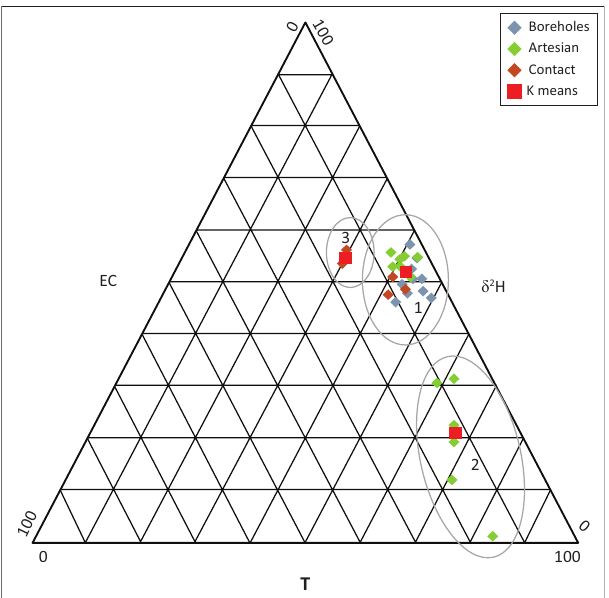
FIGURE 7: Ternary plot with normalised data (percentiles) for EC (mS/cm), temperature (°C), and δ 2 H excess for different water point types in the Etosha National Park, May 2013, inclusive of k -means centroids (north-south transect samples omitted from the analysis because of unreliable multi-parameter probe readings).